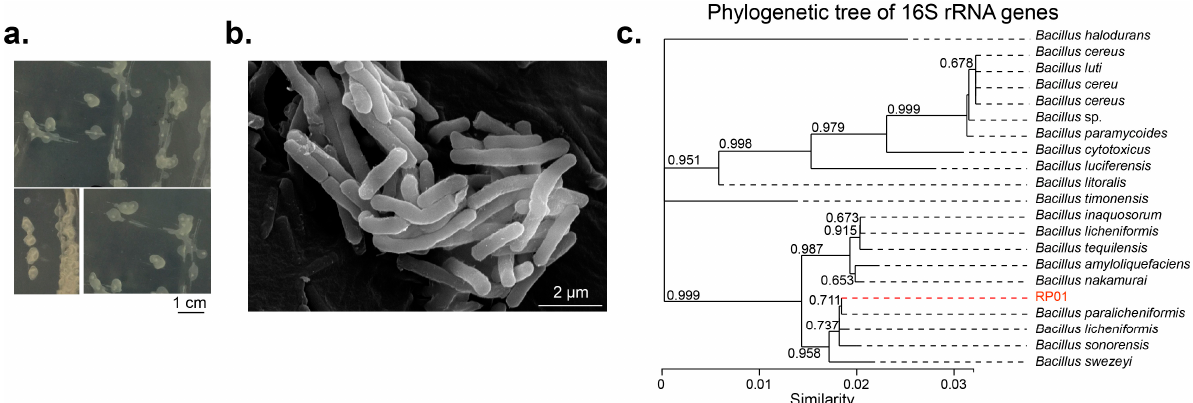
Figure 1. Morphological characteristics of Bacillus paralicheniformis RP01. ( a ) Colony phenotype of B. paralicheniformis RP01 on LB medium, scale bar represents 1 cm. ( b ) Cellular morphology under scanning electron microscope after culture for 16 h at 37 °C, scale bar represents 2 µm. ( c ) Molecular evolutionary tree for RP01 and other 20 strains in GenBank database. The tree was built using the 16S rRNA region gene (27F and 1492R) by the neighbor joining method with a bootstrap value of 1000. RP01 could use citrate and xylose as carbon sources, but not hydrolyze starch, and